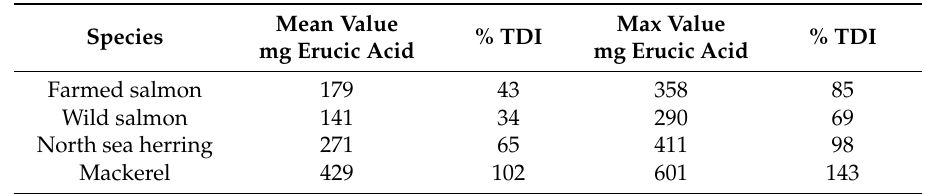
Table 3. Intake of erucic acid (22:1n-9) when consuming 200 g fish and the proportion of the Tolerable Daily Intake (TDI) of 7 mg per kg bodyweight per day, for a 60 kg person, using the mean and the maximum value for the respective fish